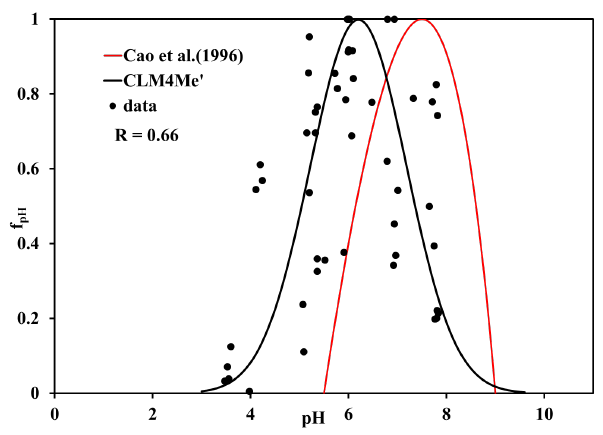
Fig. 1. PH function used in the model (Black line). The optimal pH for methanogenesis is 6.2 in our pH function. The red line shows pH function used in Cao et al. (1996) with optimal pH